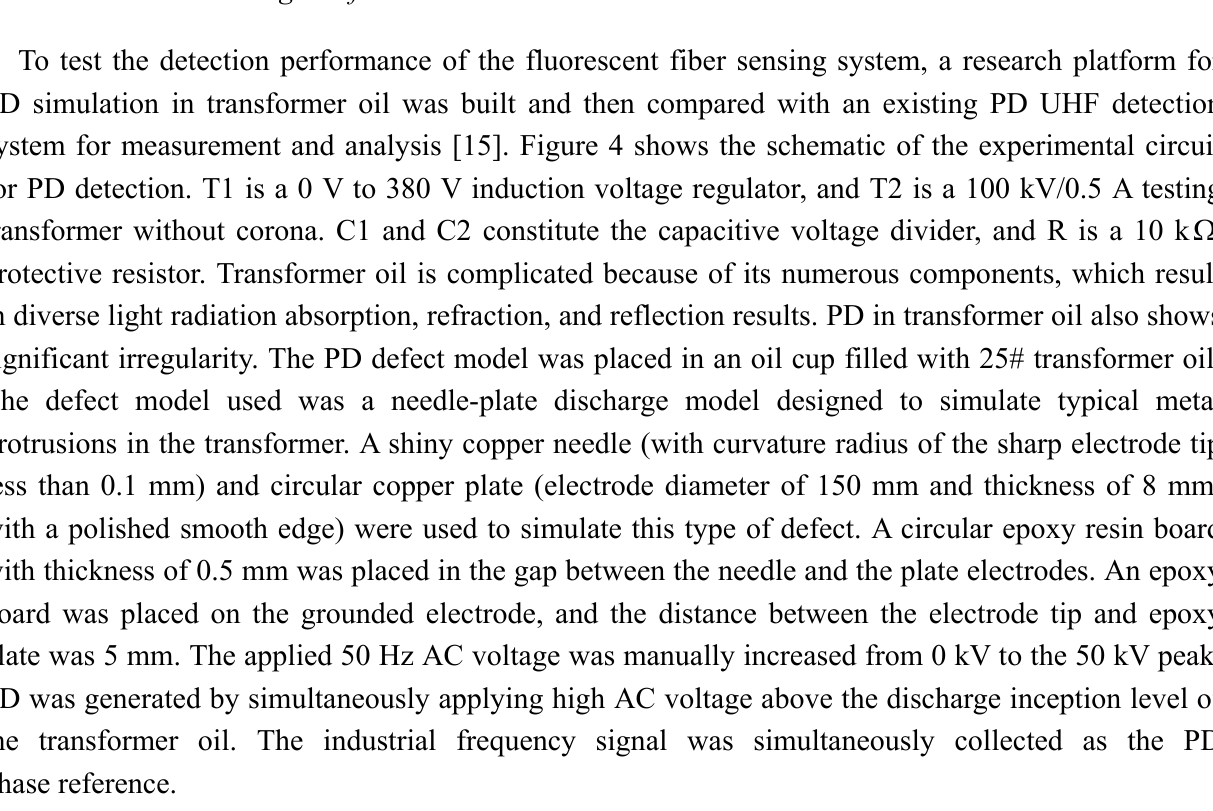
Figure 4. Experimental circuit schematic for PD optical detection platform in